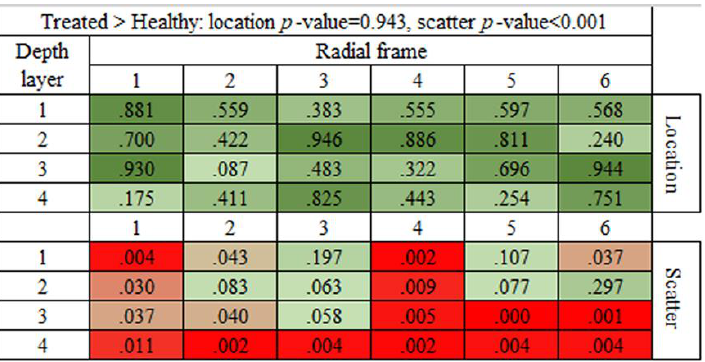
Figure 9. Heat map representing the 24 ROI (4 layers and 6 radial frames) of the cornea and the related p -values for the comparison treated vs. healthy corneas, (either in location and in scatter). The p -values < 5% are marked by a red color (more intense as the p -value gets smaller).